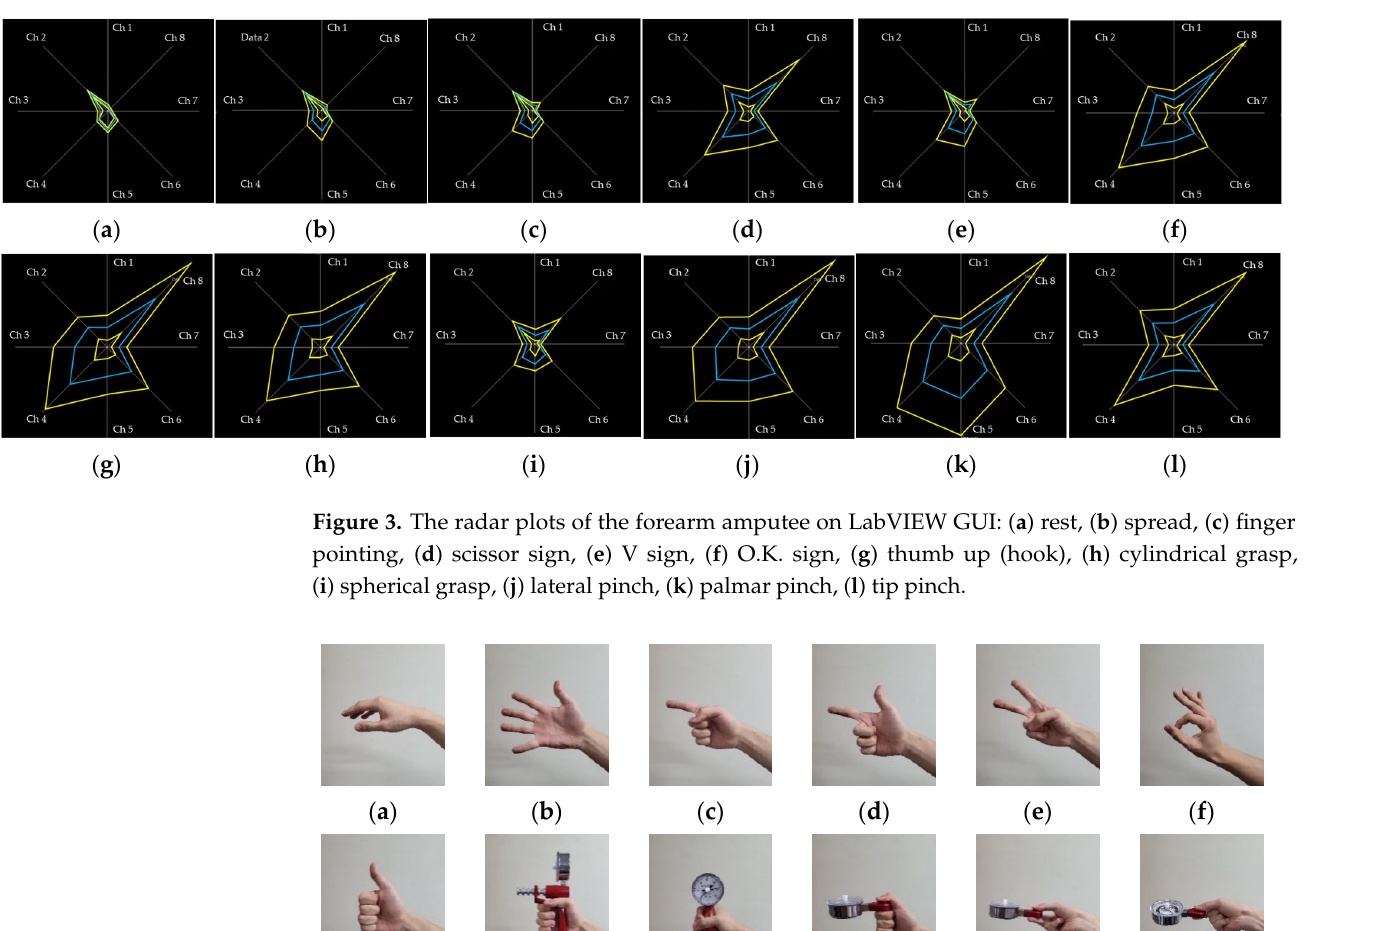
Figure 3. The radar plots of the forearm amputee on LabVIEW GUI: ( a ) rest, ( b ) spread, ( c ) finger pointing, ( d ) scissor sign, ( e ) V sign, ( f ) O.K. sign, ( g ) thumb up (hook), ( h ) cylindrical grasp, ( i ) spherical grasp, ( j ) lateral pinch, ( k ) palmar pinch, ( l ) tip pinch.